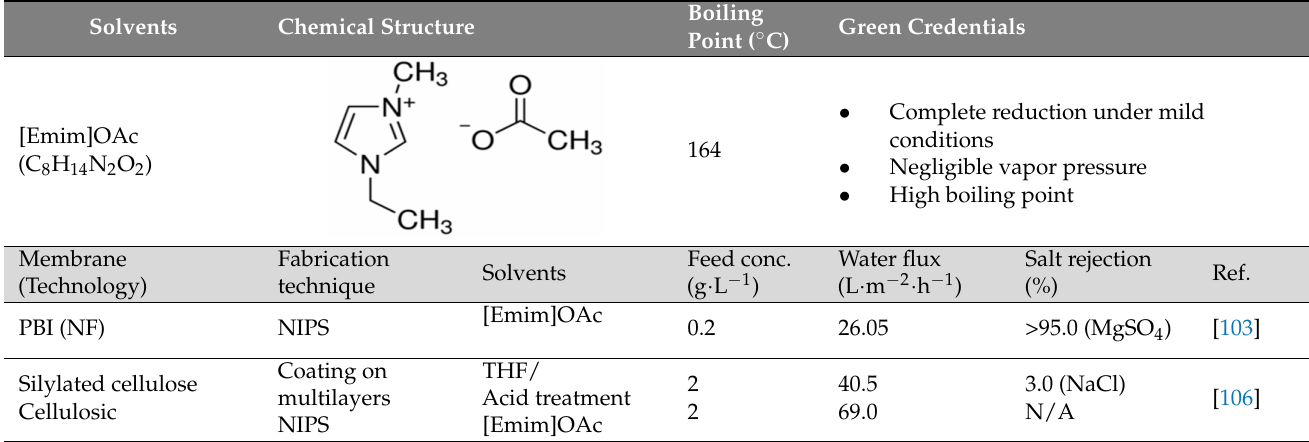
Table 5. Characteristics of ionic liquids and their summarized studies in membrane desalination.